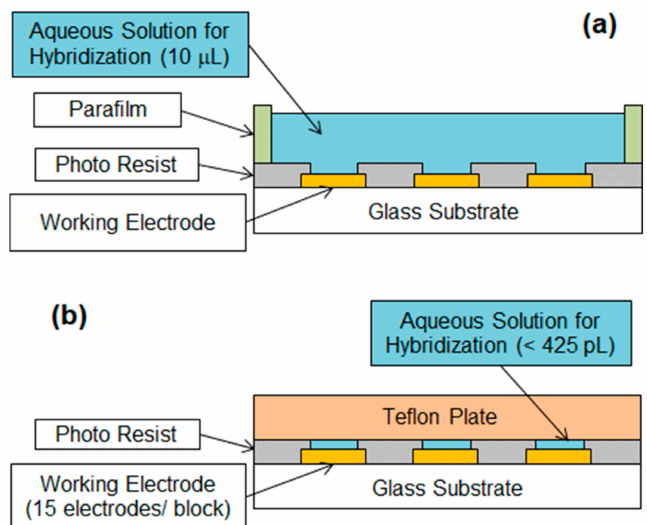
Figure 5. ( a ) Ordinary hybridization system and ( b ) new hybridization system, where a small well formed by an opening in the epoxy resin and Teflon plate limits the volume of the aqueous solution. The Teflon plate allows for the suppression of aqueous solution evaporation during hybridization and prevents the aqueous solution from being removed from each well when pressed to the array chip by a metal